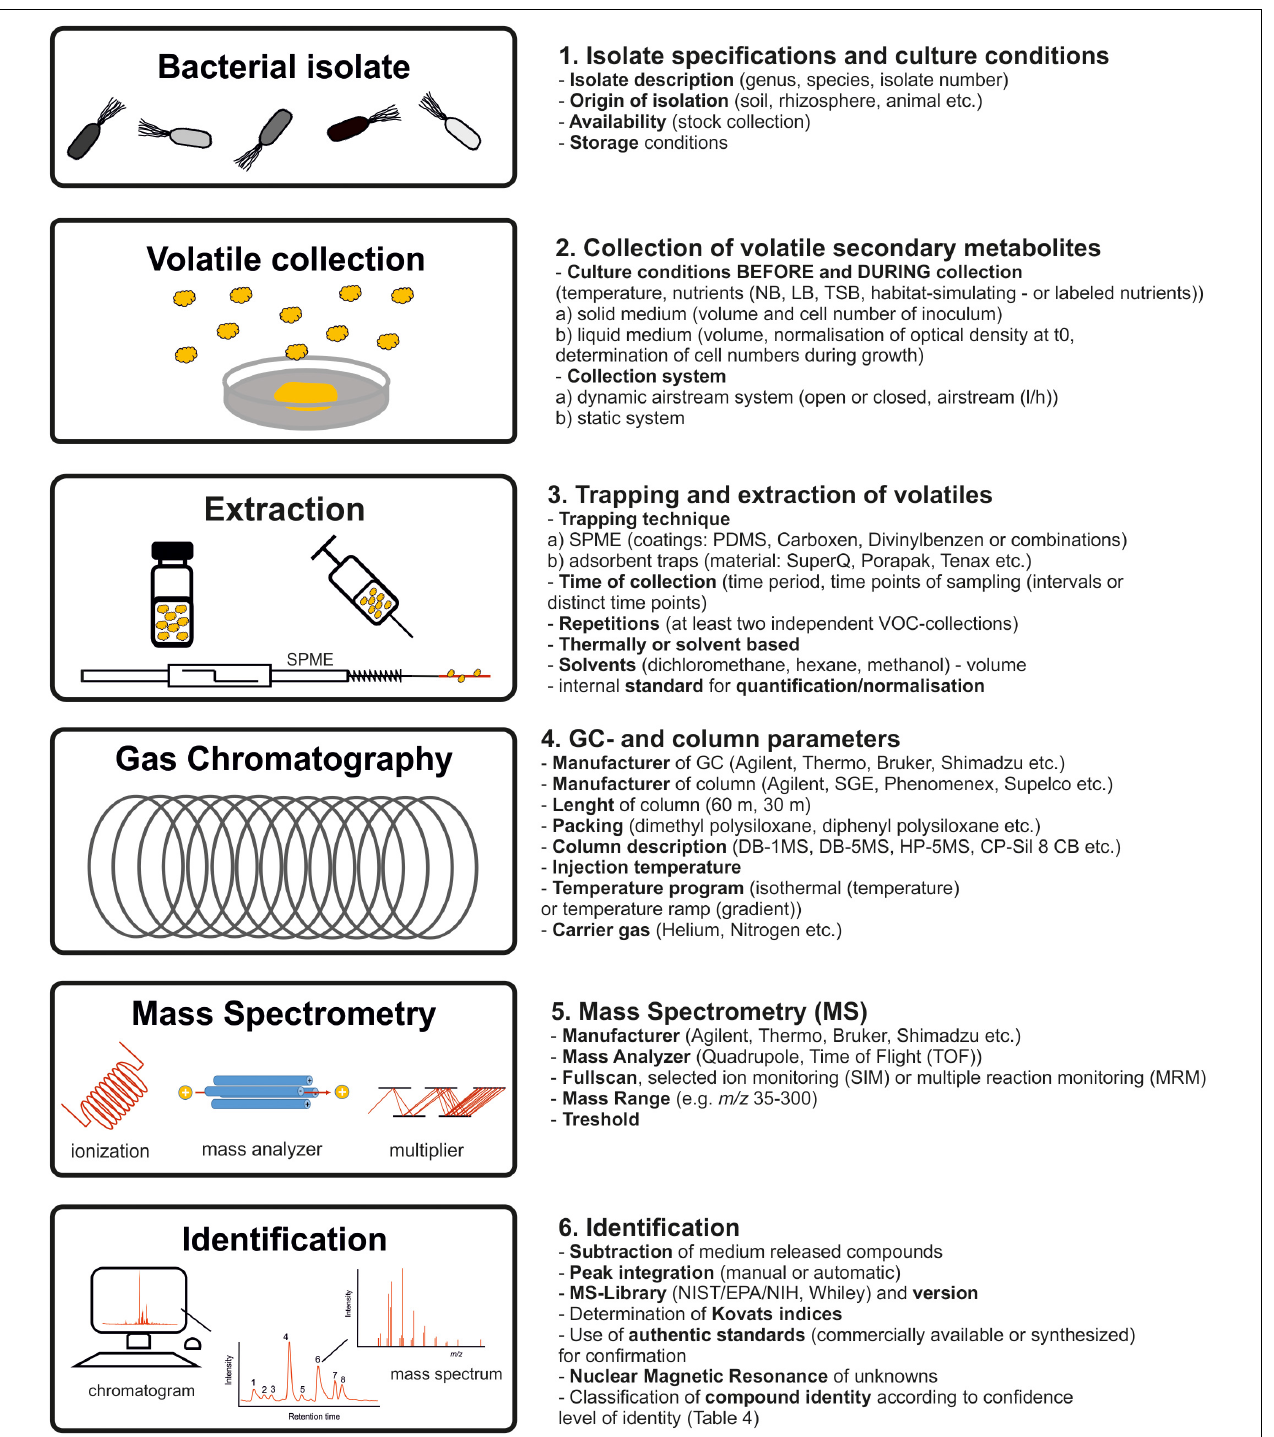
FIGURE 5 | Best practice procedures and documentation. Workflow to obtain consistent, reliable and re-usable bacterial profiles in future studies.